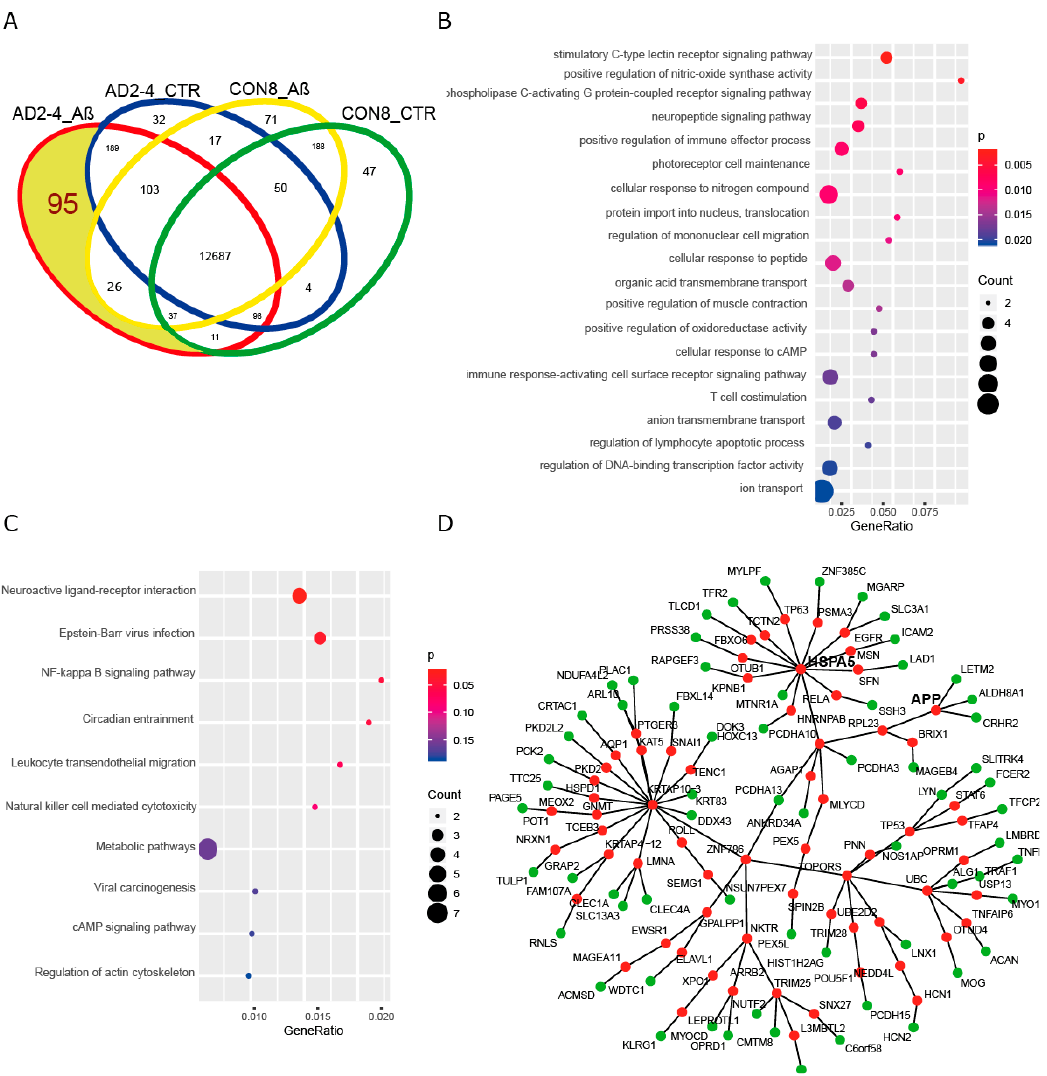
Figure 7. A β -S8C stimulated AD neuronal cultures activate a protein-protein interaction network, which includes APP and HSPA5. ( A ) Venn diagram dissecting 95 genes expressed in A β -S8C stimulated AD neuronal cultures from genes expressed in AD control and healthy neuronal cultures with and without A β -S8C stimulation. ( B ) Dot plot of gene ontologies (biological process) overrepresented in the 95 AD_A β genes. ( C ) Dot plot of KEGG pathways overrepresented in the 95 AD_A β genes. ( D ) Protein–protein interaction network derived from the 95 AD_A β genes with APP and HSPA5. Nodes from the 95 genes are colored green and the nodes added using the Biogrid database to connect the network are colored red.